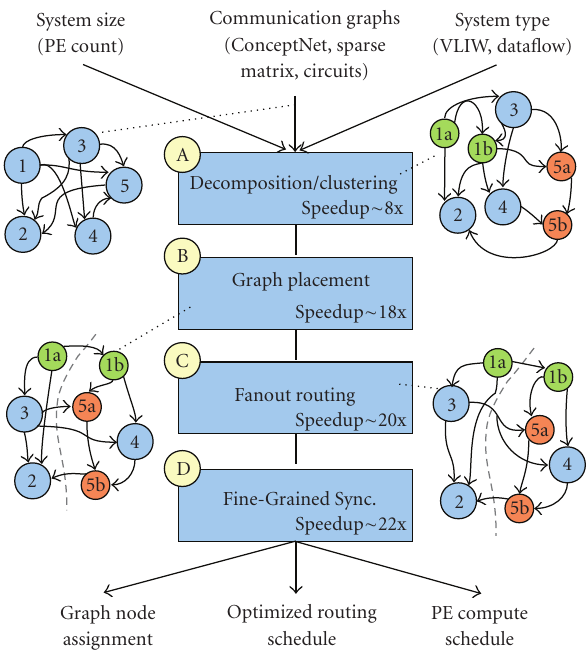
Figure 1: NoC tra ffi c compilation flow (annotated with cnet-default speedups at 2025